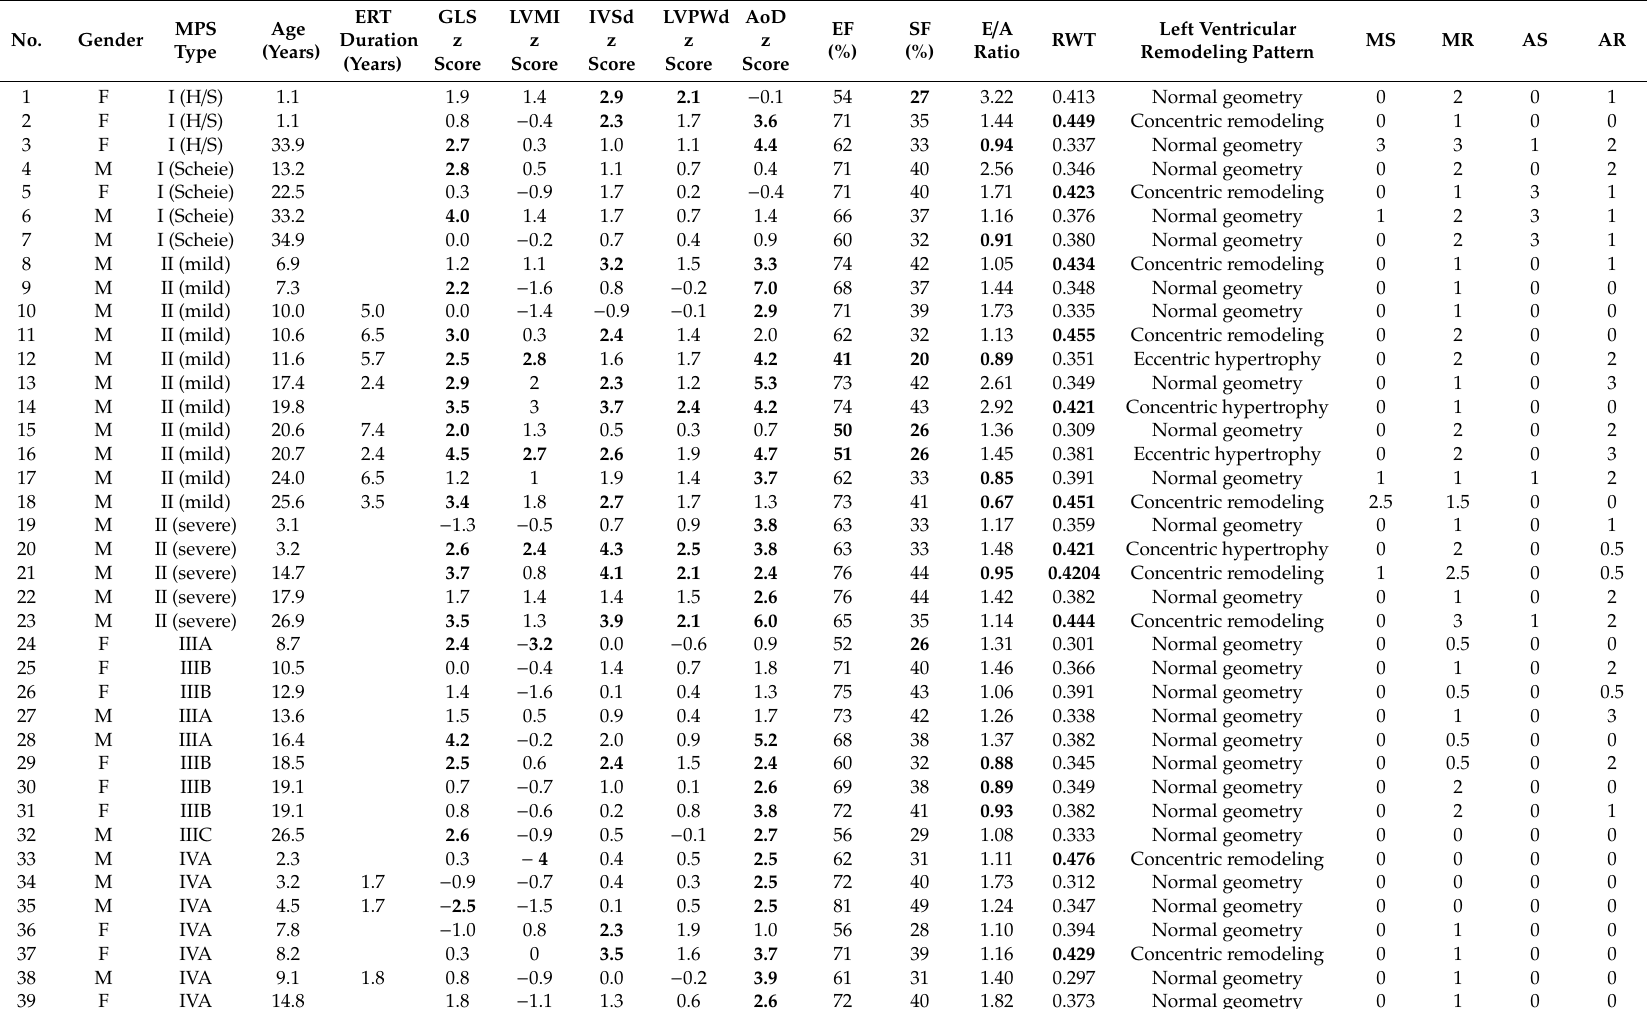
Table 1. Clinical and echocardiographic features of the 53 patients with